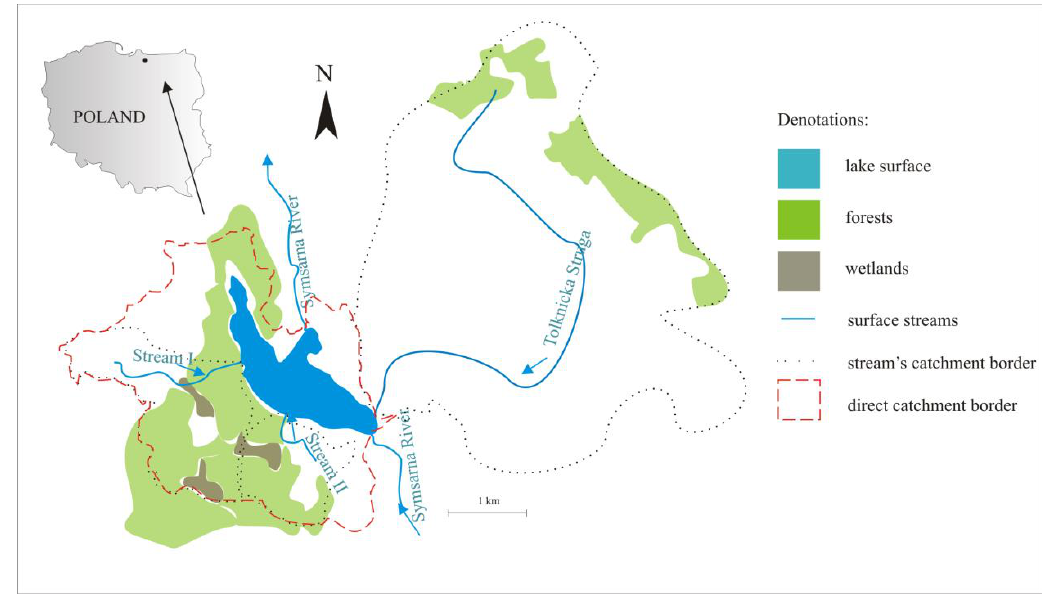
Figure 1. The use of the immediate drainage area and catchment basins of the Lake Symsar tributaries.